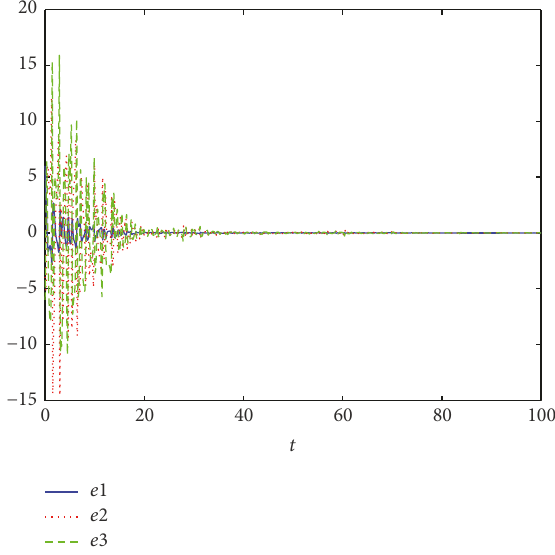
Figure 2: Asymptotic stability of error system.